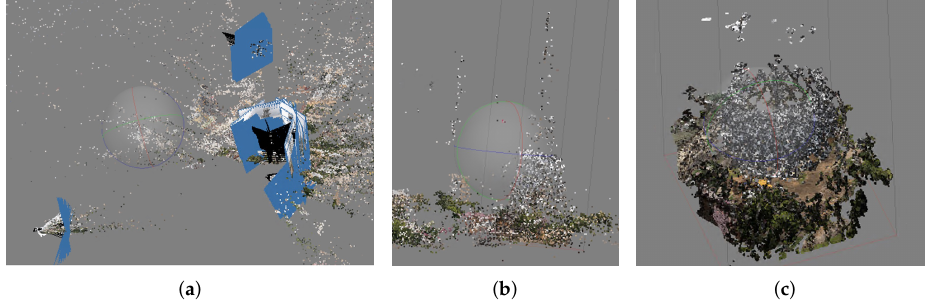
Figure 6. Image orientation ( a ), sparse point cloud ( b ) and dense point cloud ( c ) produced on a set of images by standard